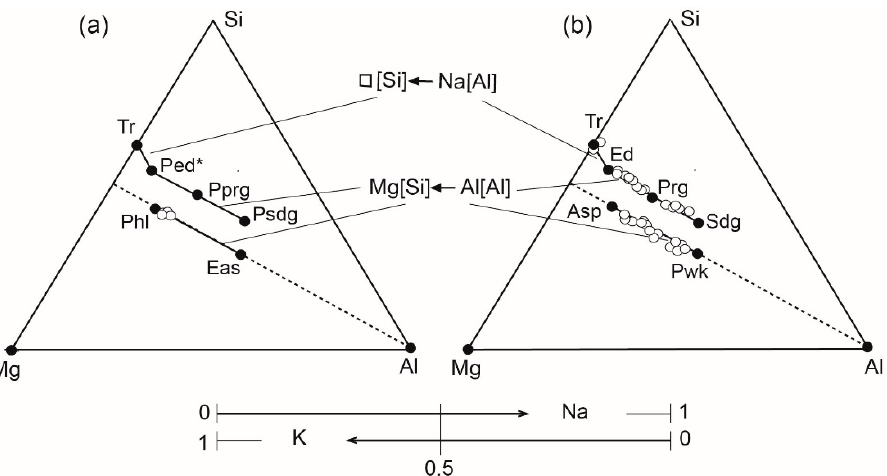
Figure 4. Chemographic representation of trioctahedral mica and calcium amphibole compositions. Mica compositions presented in the following lines: phlogopite (Phl), eastonite (Eas) for potassic micas ( a ) and aspidolite (Asp), preiswerkite (Pwk) for sodic micas ( b ). Amphibole compositions are presented in the following lines: tremolite (Tr), potassic–edenite (Ped*, theoretical), potassic–pargasite (Pprg), potassic–sadanagaite (Psdg) for potassic amphiboles (a) and tremolite (Tr), edenite (Ed), pargasite (Prg), sadanagaite (Sdg) for sodic amphiboles (b). Empty circles indicate the compositions of the Luc Yen micas and amphiboles.